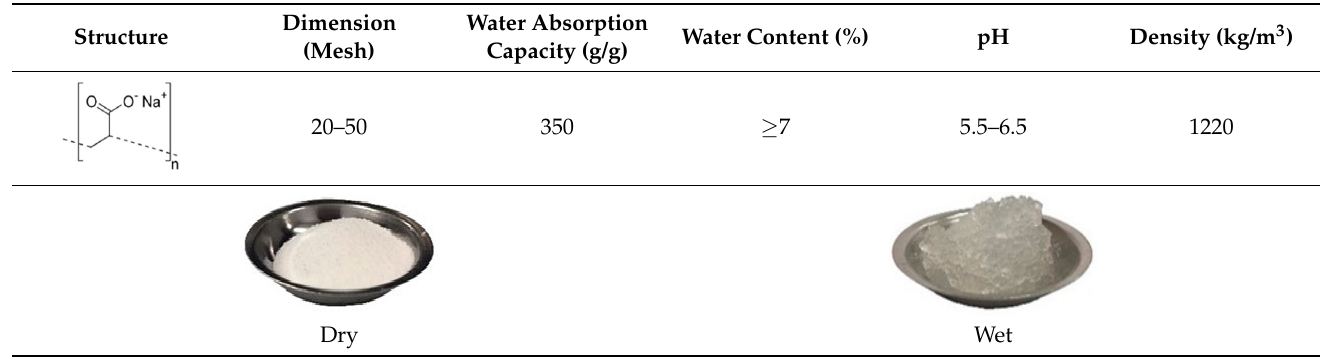
Table 1. Properties of SP.